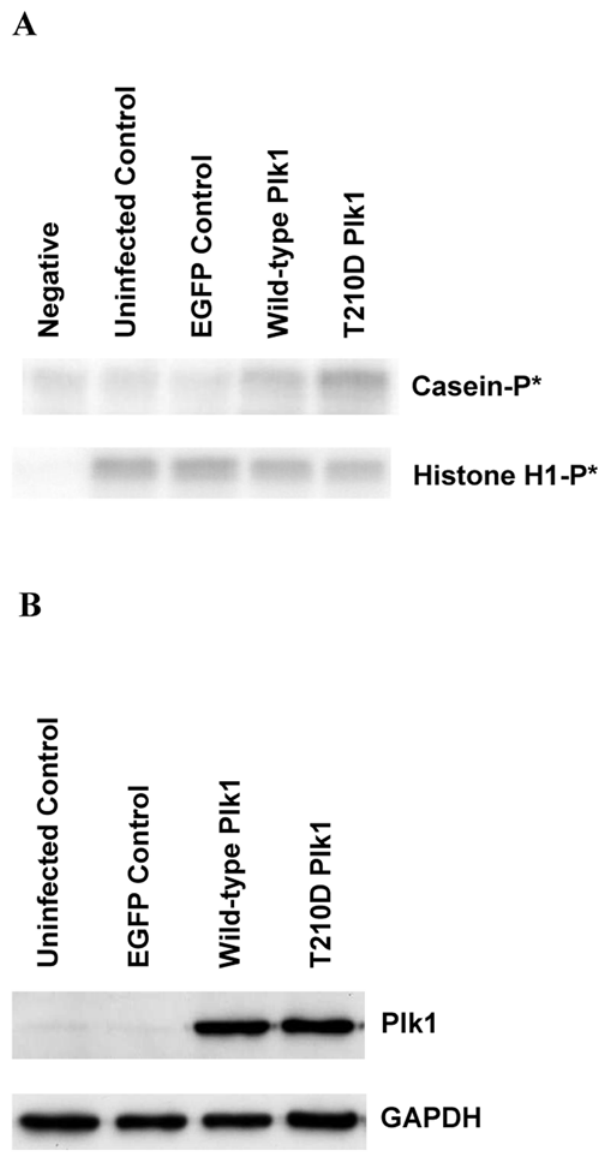
Figure 6. Exogenous Plk1 does not increase the activity of endogenous Cdc2/cyclin B1 in isolated P3 rat cardiac myo- cytes. Ventricular cardiac myocytes were isolated from Wistar rats 3 days after birth (P3). Adenovirus expressing EGFP, WT or T210D was used to infect cells for 48 hours. Cells were harvested and assessed for Plk1 and Cdc2/cyclin B1 kinase activity. Plk1 activity was assessed by its ability to phosphorylate casein (A, upper panel). Cdc2/cyclin B1 activity was assessed by phosphorylation of histone H3 (A, lower panel). B) Representative western blot of Plk1 over expression in P3 cardiac myocytes infected with EGFP, WT or T210D adenovirus. GAPDH was used to verify equal loading.